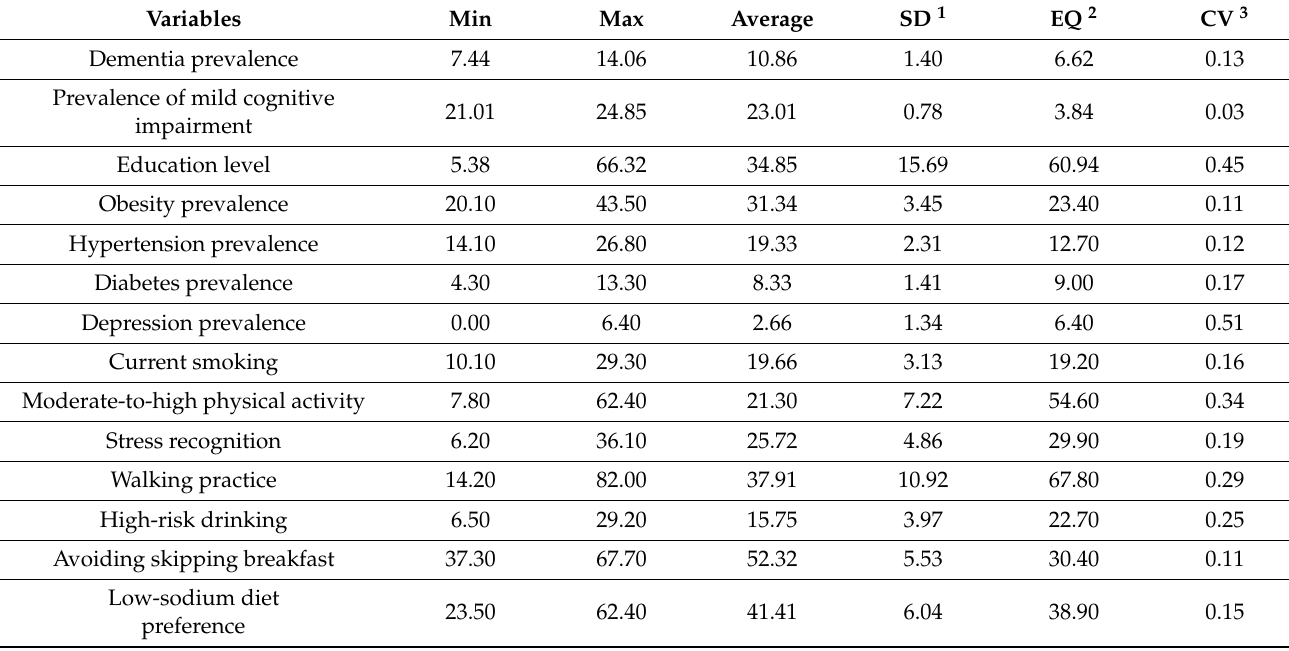
Table 2. General characteristics of study regions (246